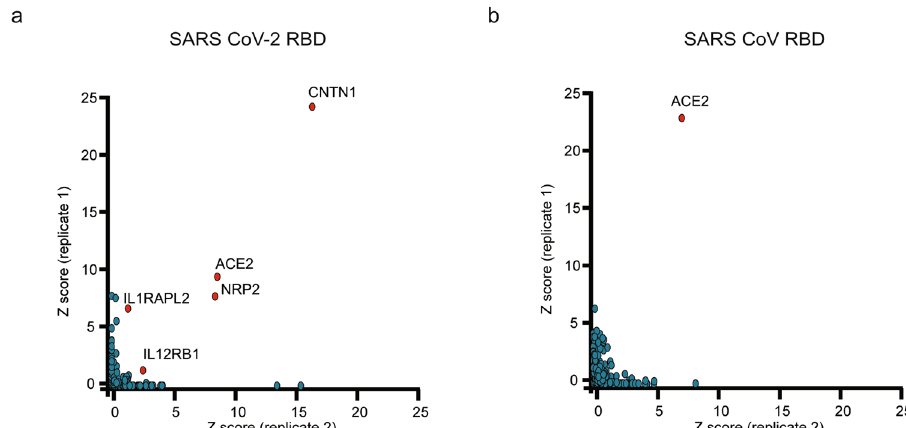
Fig. 3 Single transmembrane protein interactome screening identi fi es host cell surface factors speci fi cally targeted by the SARS CoV-2 RBD. a Intersection plot representing binding of the RBD of the SARS CoV-2 spike protein to the library of single transmembrane-containing human proteins, screened in duplicate. ACE2, IL12RB1, IL1RAPL2, CNTN1 and NRP2 were identi fi ed as speci fi c, high scoring hits. b Intersection plot representing binding of the RBD of the SARS CoV protein to the library of single transmembrane-containing human proteins, screened in duplicates. ACE2 was identi fi ed as high scoring